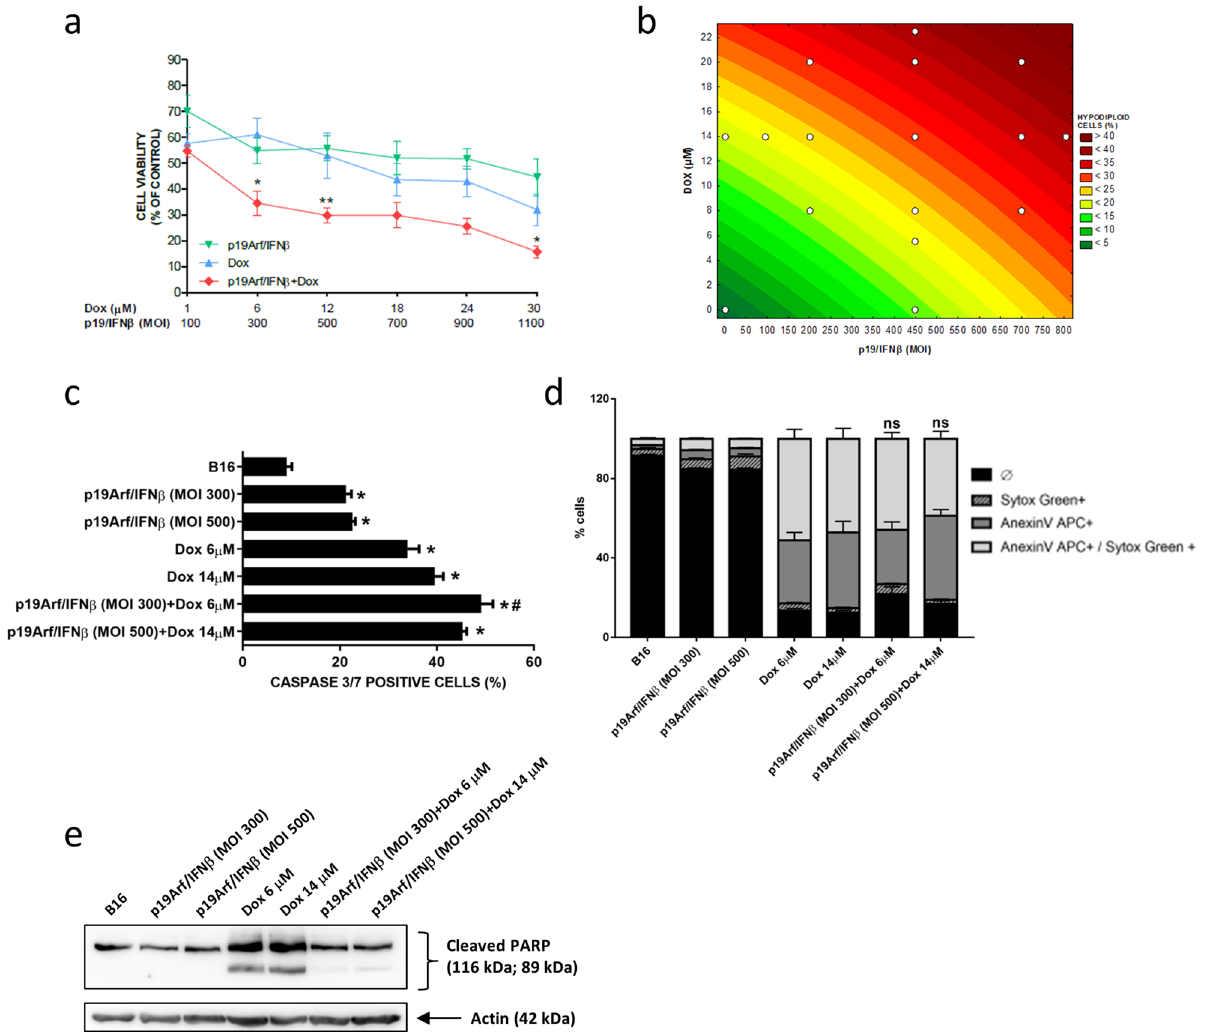
Figure 3. In vitro association of p19Arf/IFNβ and doxorubicin augments cell death levels. ( a ) MTT analysis of B16 cells treated for 12 h individually or in combination with doxorubicin and AdRGD-PG-p19 and AdRGD- PG-IFNβ vectors. n = 4 [One-way Anova and Tukey’s multiple comparison post-test]. ( b ) Response surface plot illustrating the influence of different p19Arf/IFNβ MOIs and doxorubicin concentrations on the percentage of hypodiploid MCA cells after 20 h of treatment, for which interactions were considered significant by the ANOVA and Pareto chart analysis. ( c ) Flow cytometry analysis of caspase 3 activity in B16 cells after 16 h of p19Arf/IFNβ and of doxorubicin treatment. Each assay performed on 3 independent occasions with technical duplicates. One-way Anova with Sidak’s post-test. *p < 0.0001 vs CTR; # p < 0.0001 p19Arf/IFNβ + Dox vs p19Arf/IFNβ or Dox. ( d ) Fresh B16 cells, treated as indicated, were stained to reveal apoptotic cells (AnnexinV APC +) or advanced cell death (Sytox Green +) before observation by flow cytometry. Each assay performed on 3 independent occasions with technical duplicates. Two-way Anova with Tukey’s post-test. ( e ) Representative image of two independent Western blot experiments for detection of cleaved PARP upon treatment of B16